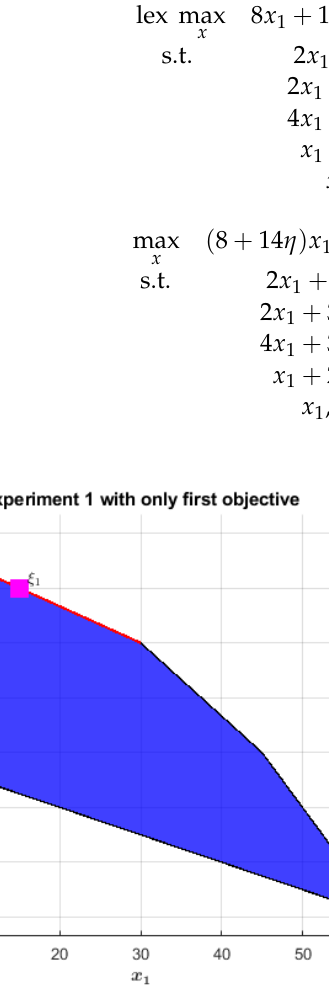
Figure 1. The optimal segment for the primary objective is in red; ξ 1 is the optimal point a standard IPM would